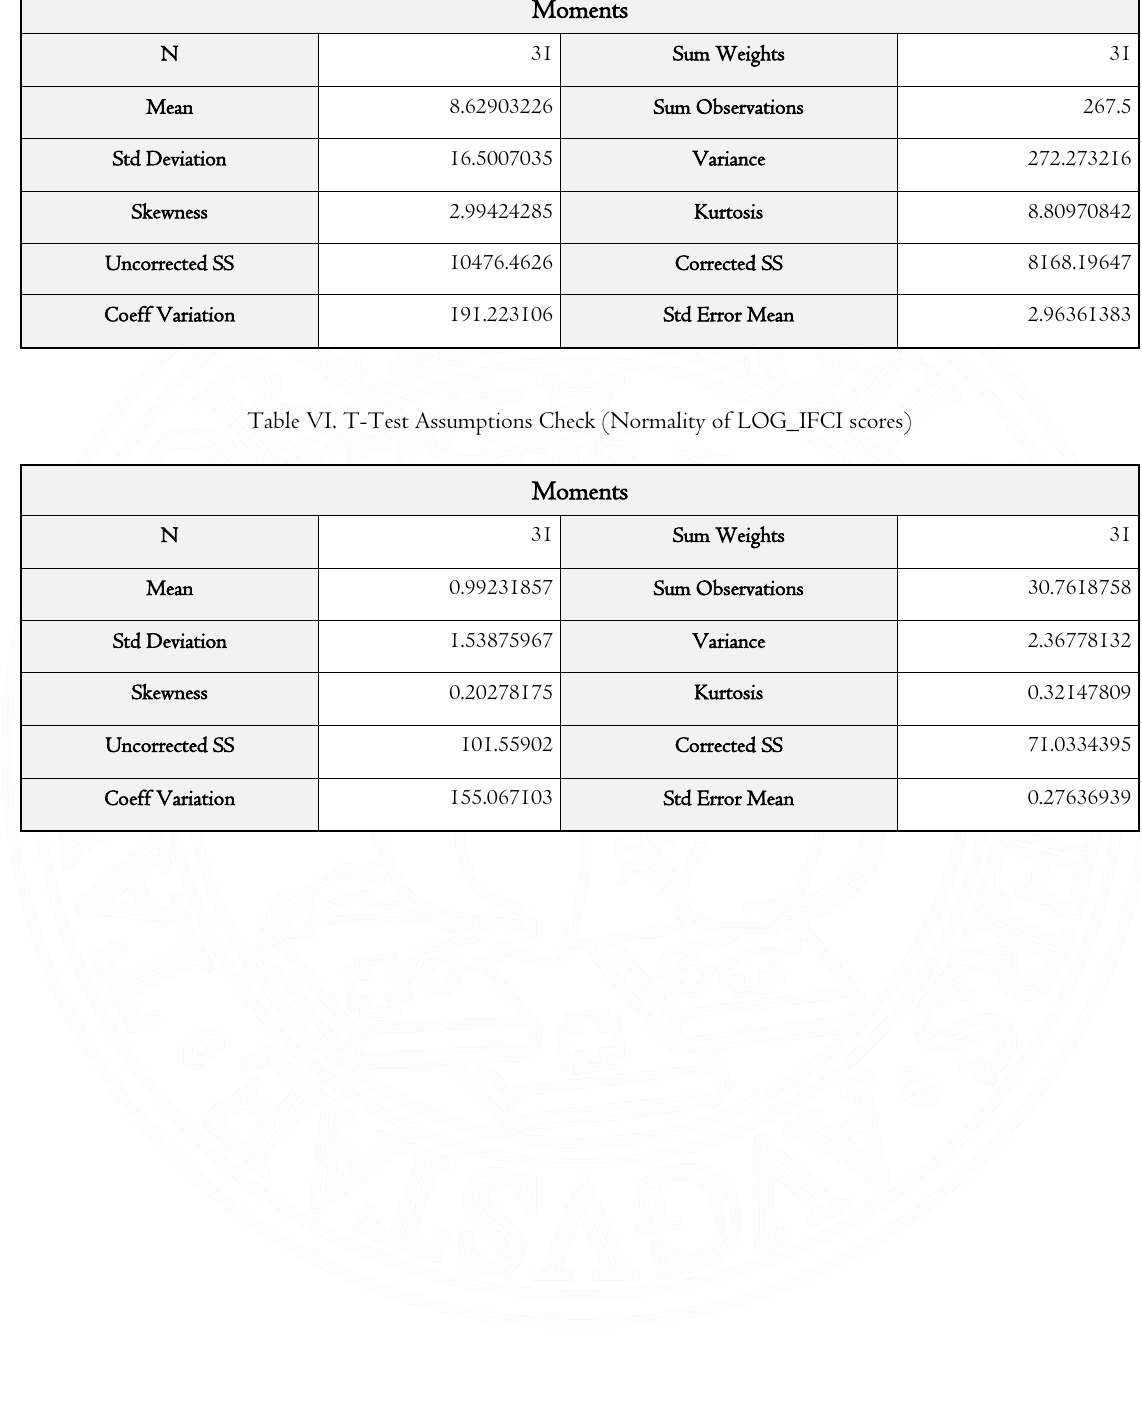
Table V. Assumptions Check (Normality of IFCI scores) Moments